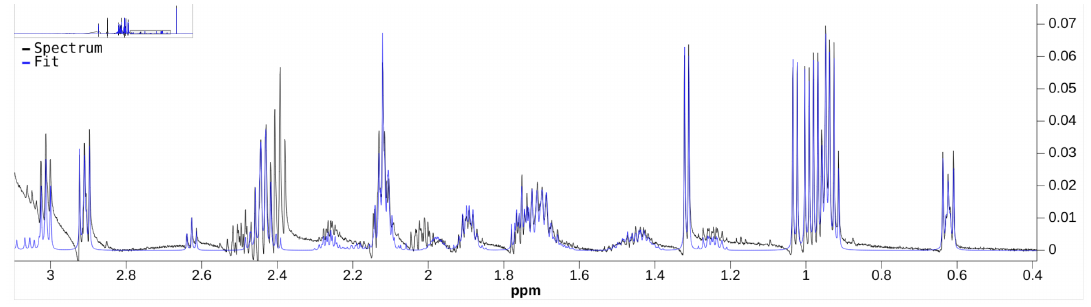
Figure 5. Close-up of Figure 4.